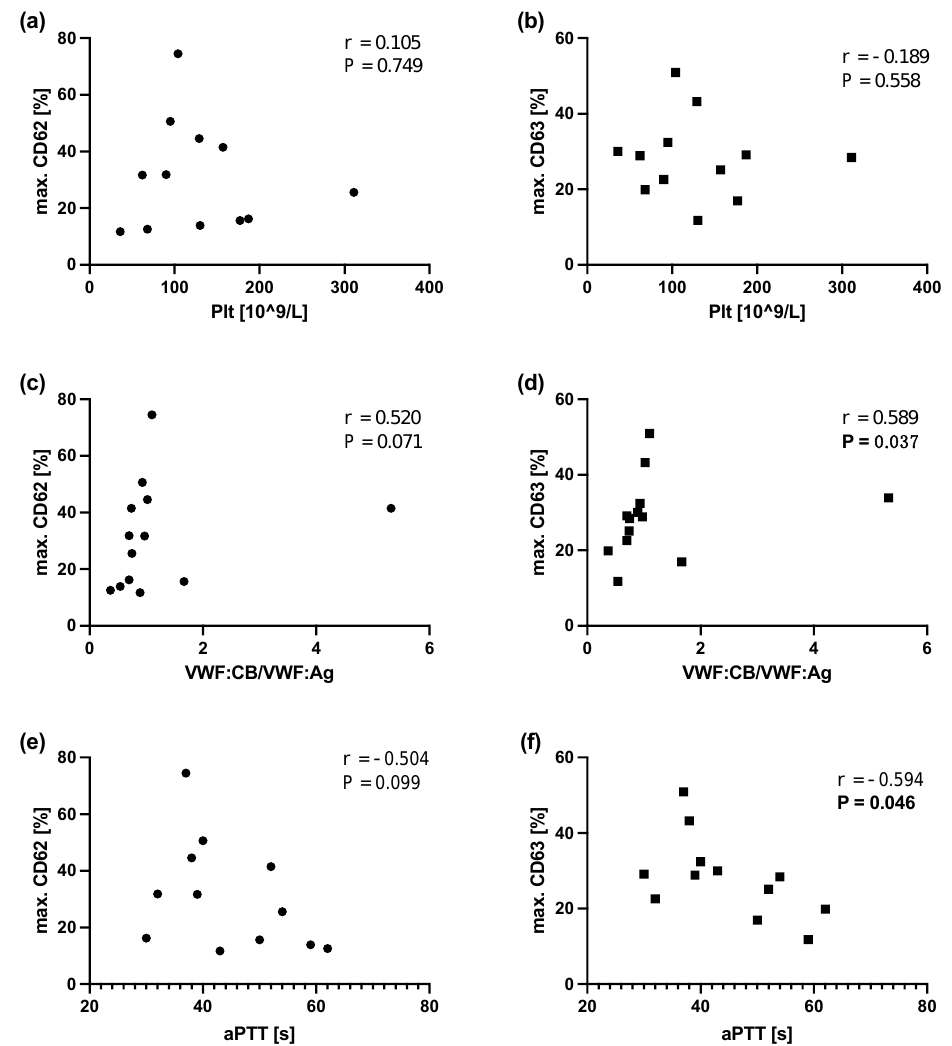
Figure 4. Spearman correlation analyses between maximum CD62/CD63 expression after incubation with 1 U/mL thrombin with platelet counts ( a , b ), VWF:CB/VWF:Ag ratio ( c , d ), and aPTT ( e , f ).